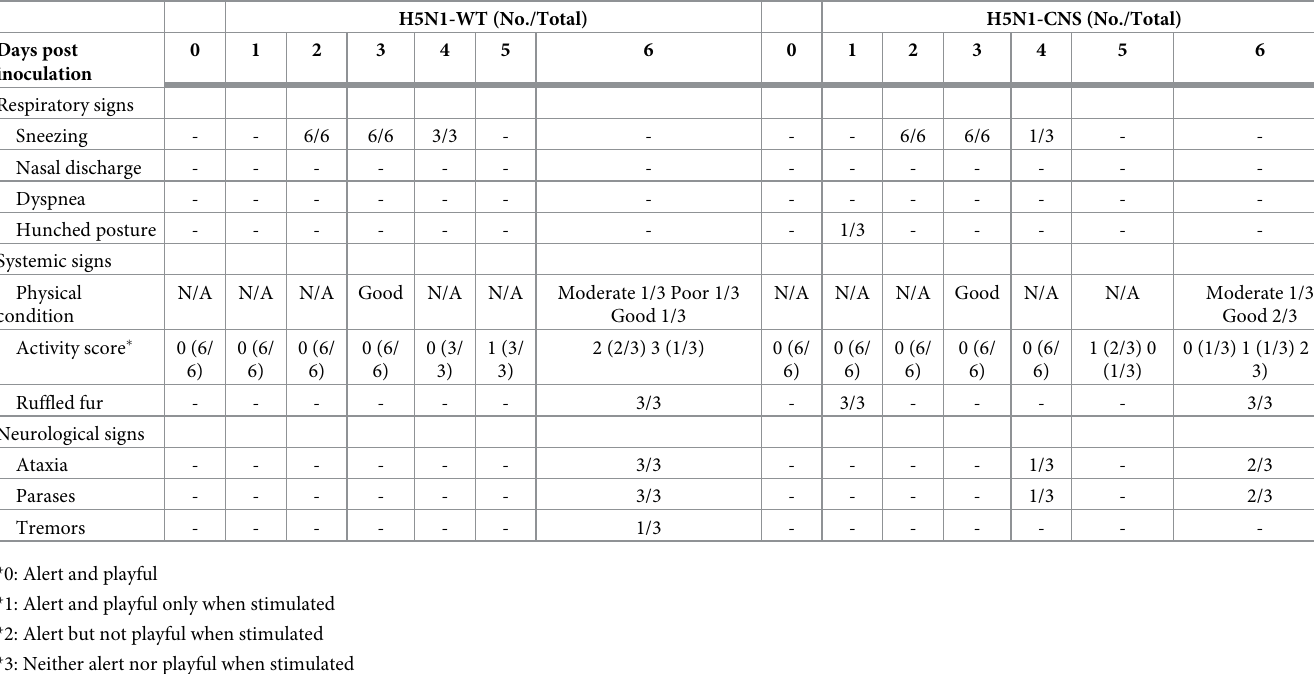
Table 2. Clinical signs in H5N1-WT and H5N1-CNS virus inoculated